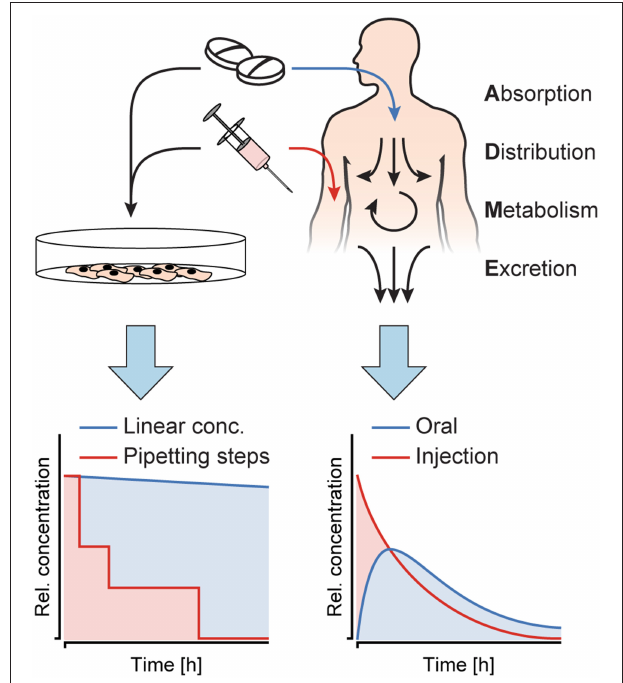
FIGURE 1 | Substance concentration profiles in in vitro experiments as opposed to in vivo . Cell culture models in vitro are exposed to constant concentrations or sudden substance concentration steps generated by pipetting, while in the human body, the interplay of absorption, distribution, metabolism and excretion (ADME) produces distinct, dynamic substance concentration profiles upon oral administration or injection of a